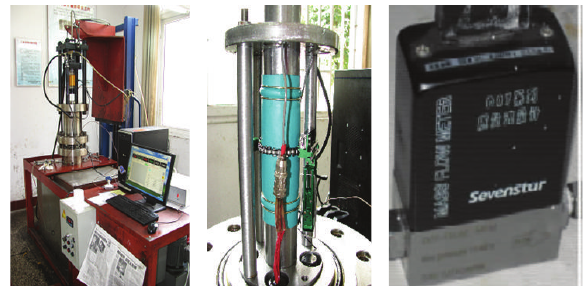
Figure 1: Thermo-fluid-solid coupling with triaxial servocontrolled seepage equipment of methane-containing coal.